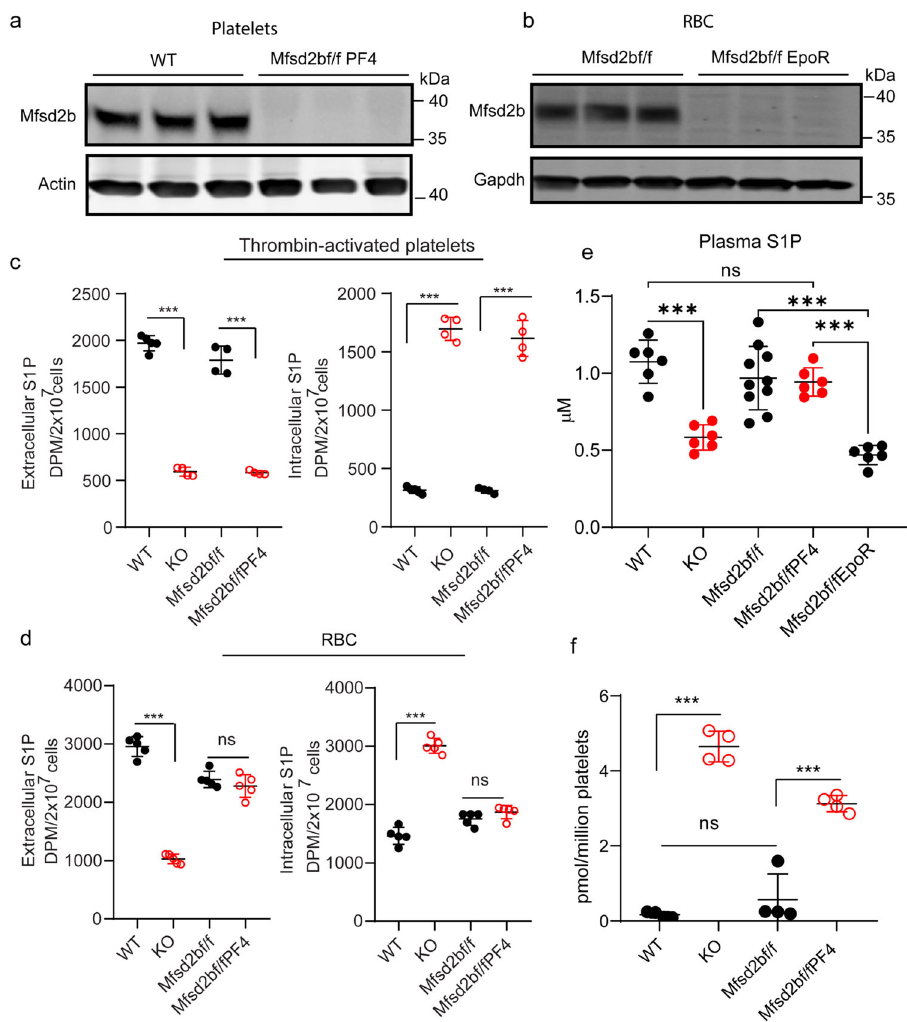
Fig. 4 Platelets play a dispensable role for plasma S1P. a , b Western blot analysis of Mfsd2b expression in platelets and erythrocytes from WT, Mfsd2bf/ fPF4, and Mfsd2bf/fEpoR mice. Experiments were performed at least twice with n = 3. WT wild-type, KO knockout, RBC red blood cells. c Extracellular and intracellular S1P levels from transport assays with thrombin-activated platelets from the indicated mice to evaluate the ability of S1P export. Similar to platelets from global knockout of Mfsd2b, platelets from PF4-Cre speci fi c knockout of Mfsd2b (Mfsd2bf/fPF4) had a reduced S1P transport activity comparable to platelets isolated from global KO and control (Mfsd2bf/f). Data are mean and SD. Experiments were performed at least twice with n = 4. *** P < 0.001; ns not signi fi cant. One-way ANOVA was used. d Extracellular and intracellular S1P levels from transport assays of isolated erythrocytes to evaluate the ability of S1P export. Erythrocytes isolated from Mfsd2bf/fPF4 had normal S1P transport activity, whereas S1P export activity is reduced in global Mfsd2b KO erythrocytes. Data are mean and SD. Experiments were performed at least twice with n = 4. *** P < 0.001; ns not signi fi cant. One-way ANOVA was used. e Total plasma S1P levels from WT ( n = 6), global Mfsd2b KO ( n = 6), Mfsd2bf/fPF4 ( n = 6), Mfsd2bf/fEpoR ( n = 6) knockout mice, and Mfsd2bf/f mice ( n = 10). Data are mean and SD. *** P < 0.001. ns not signi fi cant. One-way ANOVA was used. f S1P levels in platelets isolated from the indicated genotypes. Data are mean and SD. Each dot represents one animal ( n = 4). *** P < 0.001; ns not signi fi cant. One-way ANOVA was used. DPM disintegrations per